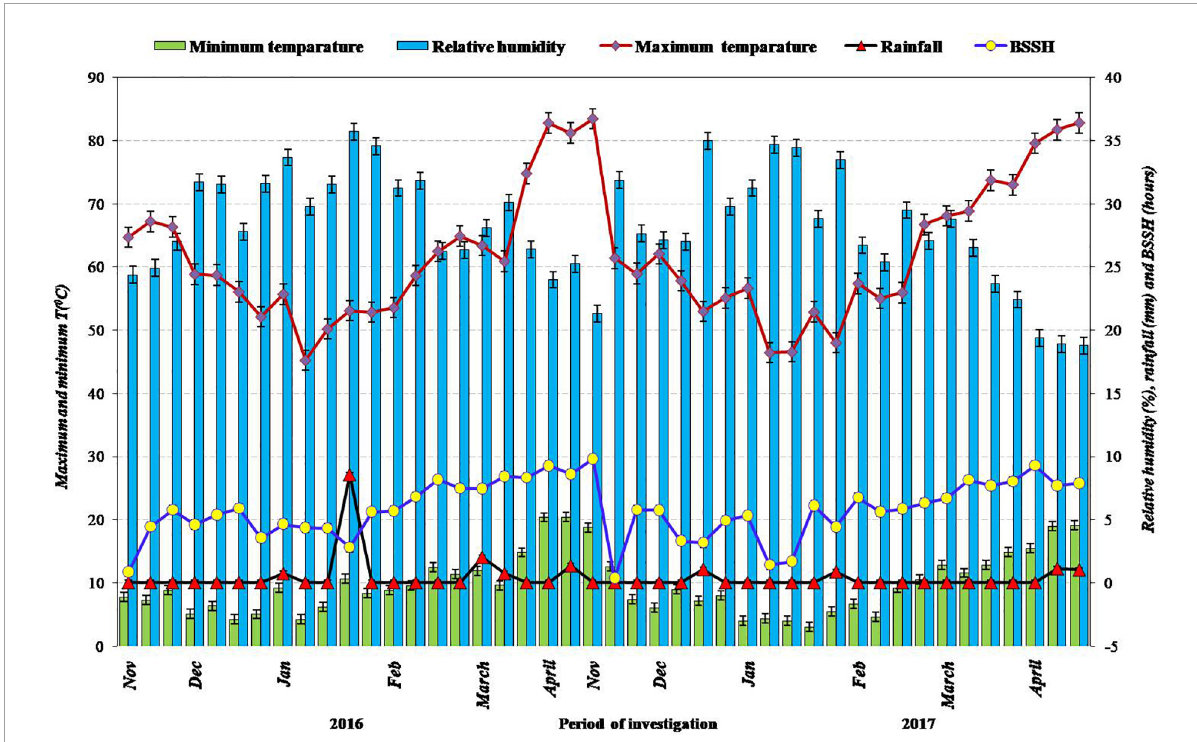
FIGURE1 Meteorological data during the period of investigation during 2016 and 2017, respectively.